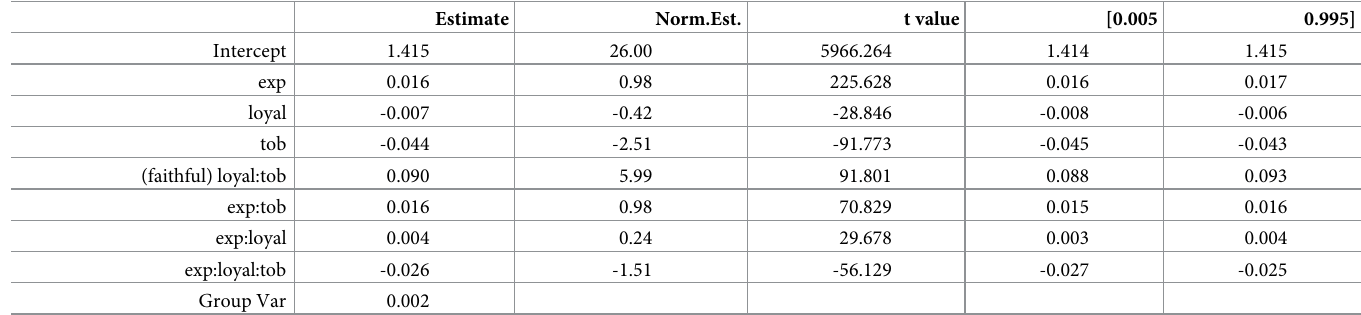
Table 2. Linear mixed model for one overall model fitted to all data between 10 and 500 games played of individual experience. At column normalized estimates (Norm.Est.) we transform the estimators, in logarithmic scale, to their normalized value, (e.g. Intercept = 10 1.415 , exp = 10 1.415+ 0.016 − 10 1.415 ). Method: REML converged. Number of groups: 65335. Max Group size: 491. Mean group size: 99.5.